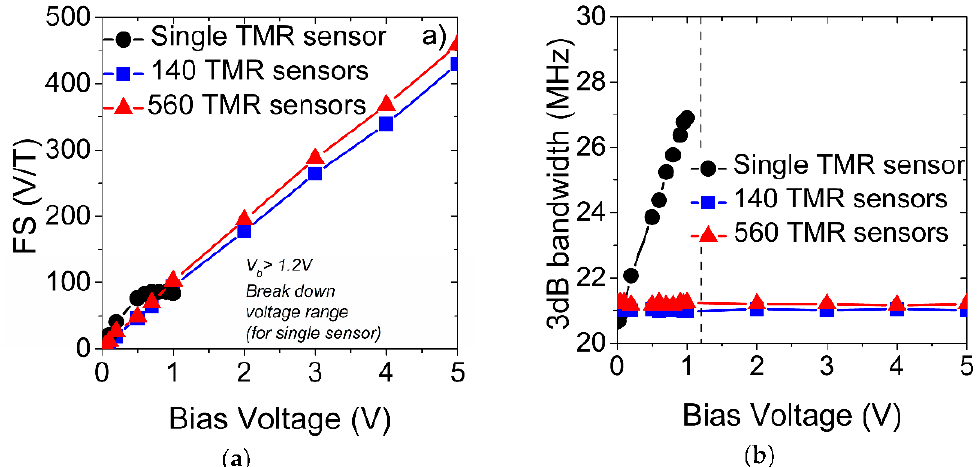
Figure 3. Sensitivity (FS) ( a ) and 3 dB bandwidth ( b ) dependence on bias voltage for single and series-connected sensors.